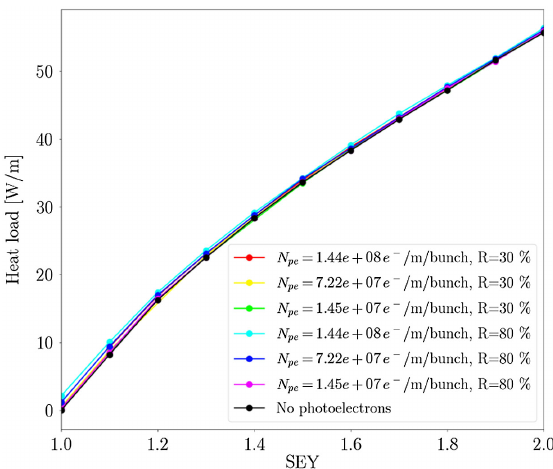
FIG. 3. Heat load as a function of SEY for arc dipoles in case of no photoelectrons and different values of photoelectrons and